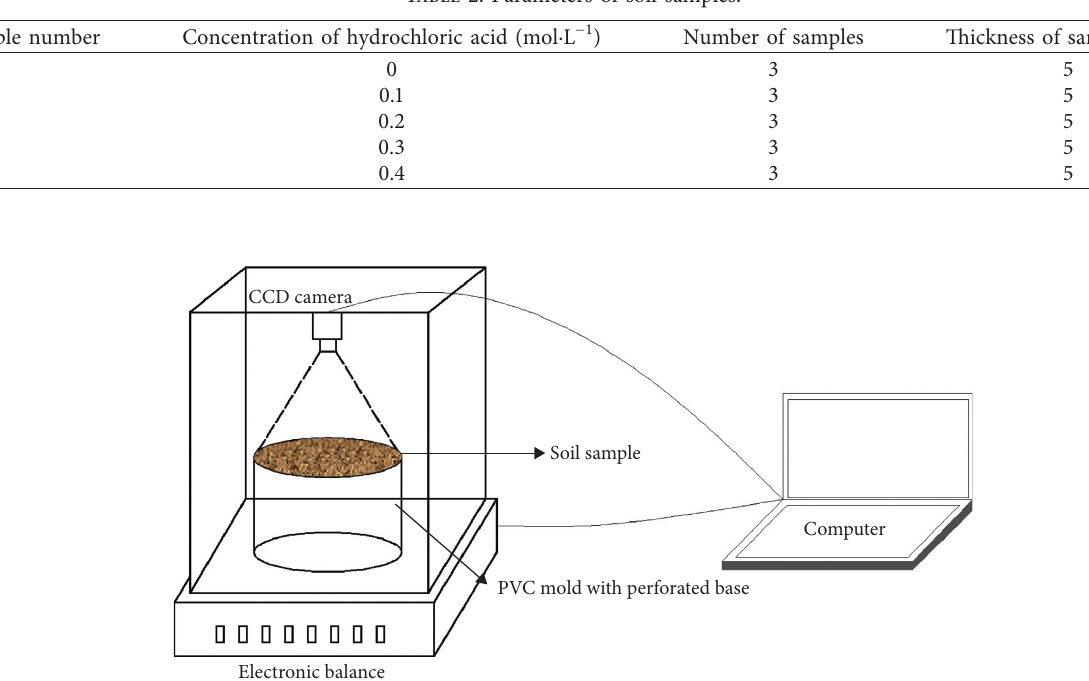
Figure 2: Schematic of laboratory